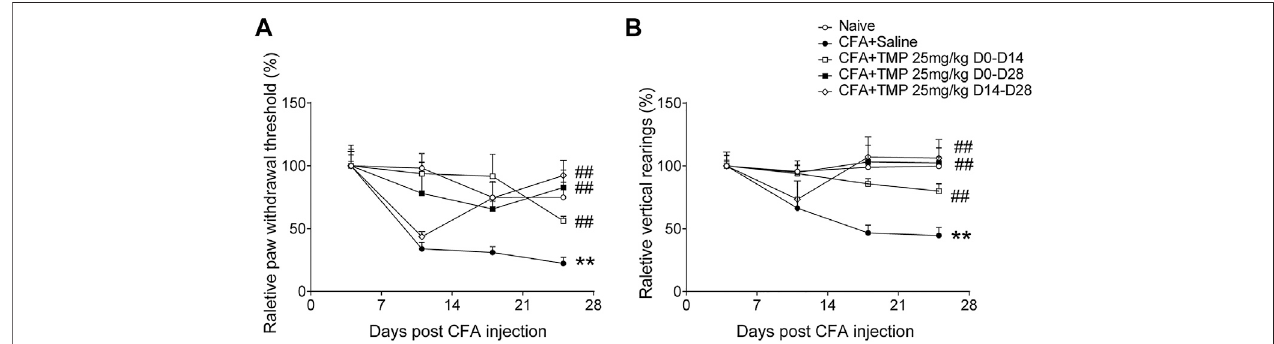
FIGURE 6 | The analgesic effects of TMP on the initiation and maintenance of CFA induced pain. (A) The relative paw mechanical pain threshold and (B) vertical rearings with different TMP administration periods. Statistical comparison was performed with repeated measures two-way ANOVA with post Dunnett ’ s multiple comparisons (## p < 0.01, vs. CFA+Saline; ** p < 0.01, vs. Naïve).